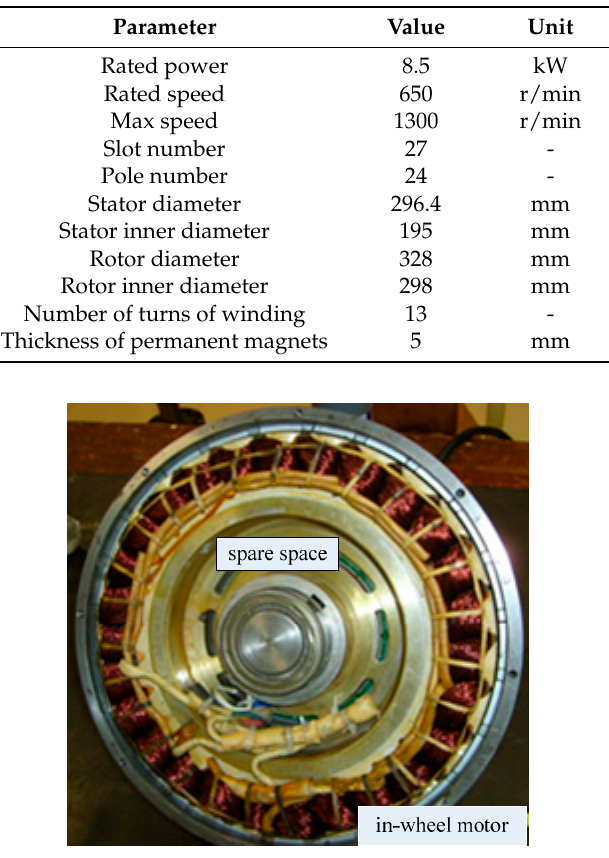
Table 1. Main parameters of the conventional in-wheel motor prototype.